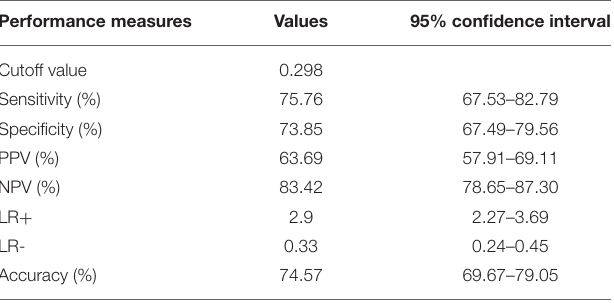
TABLE 4 | Performance of the prediction Nomo score for estimating the risk of FOG. Performance